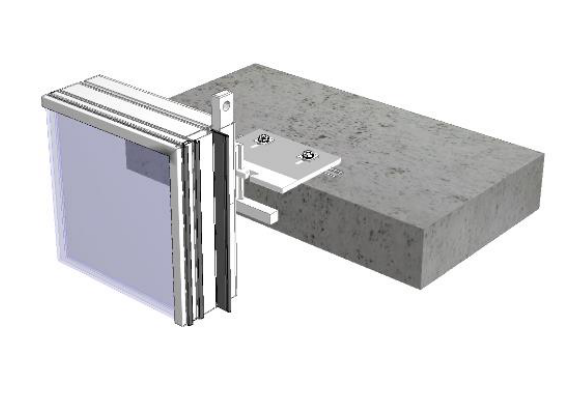
Fig. 5 3D view of a hung & sworded